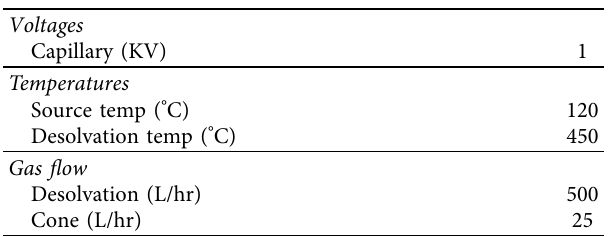
Table 2: MS tune conditions.